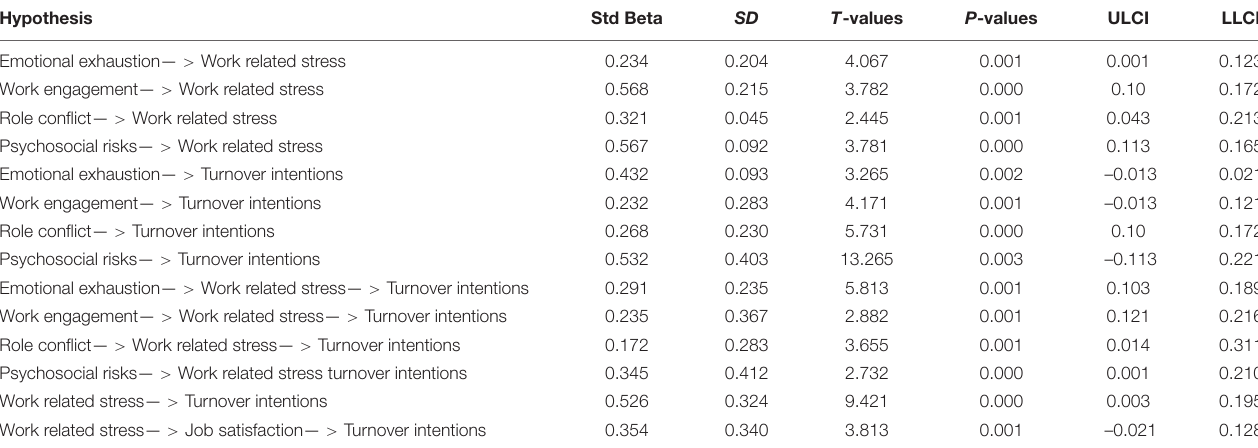
TABLE 4 | Hypothesis